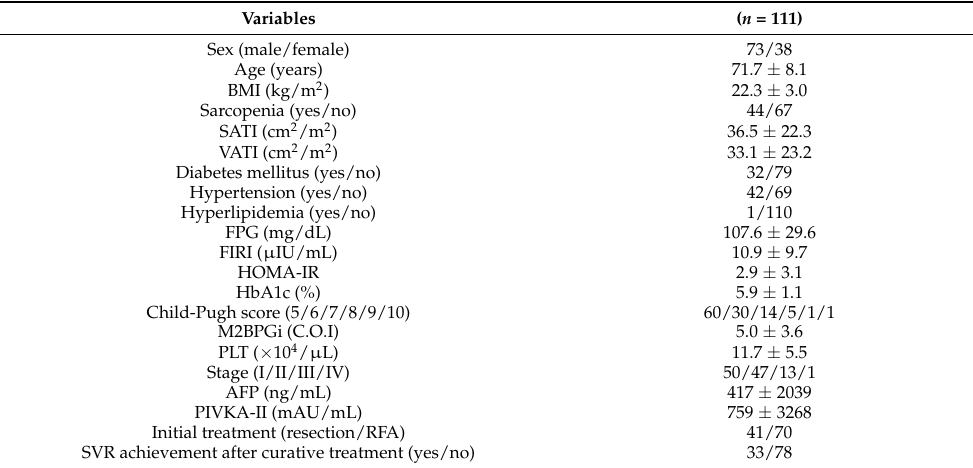
Table 1. Baseline demographic and clinical characteristics of the participants during initial hepatocel- lular